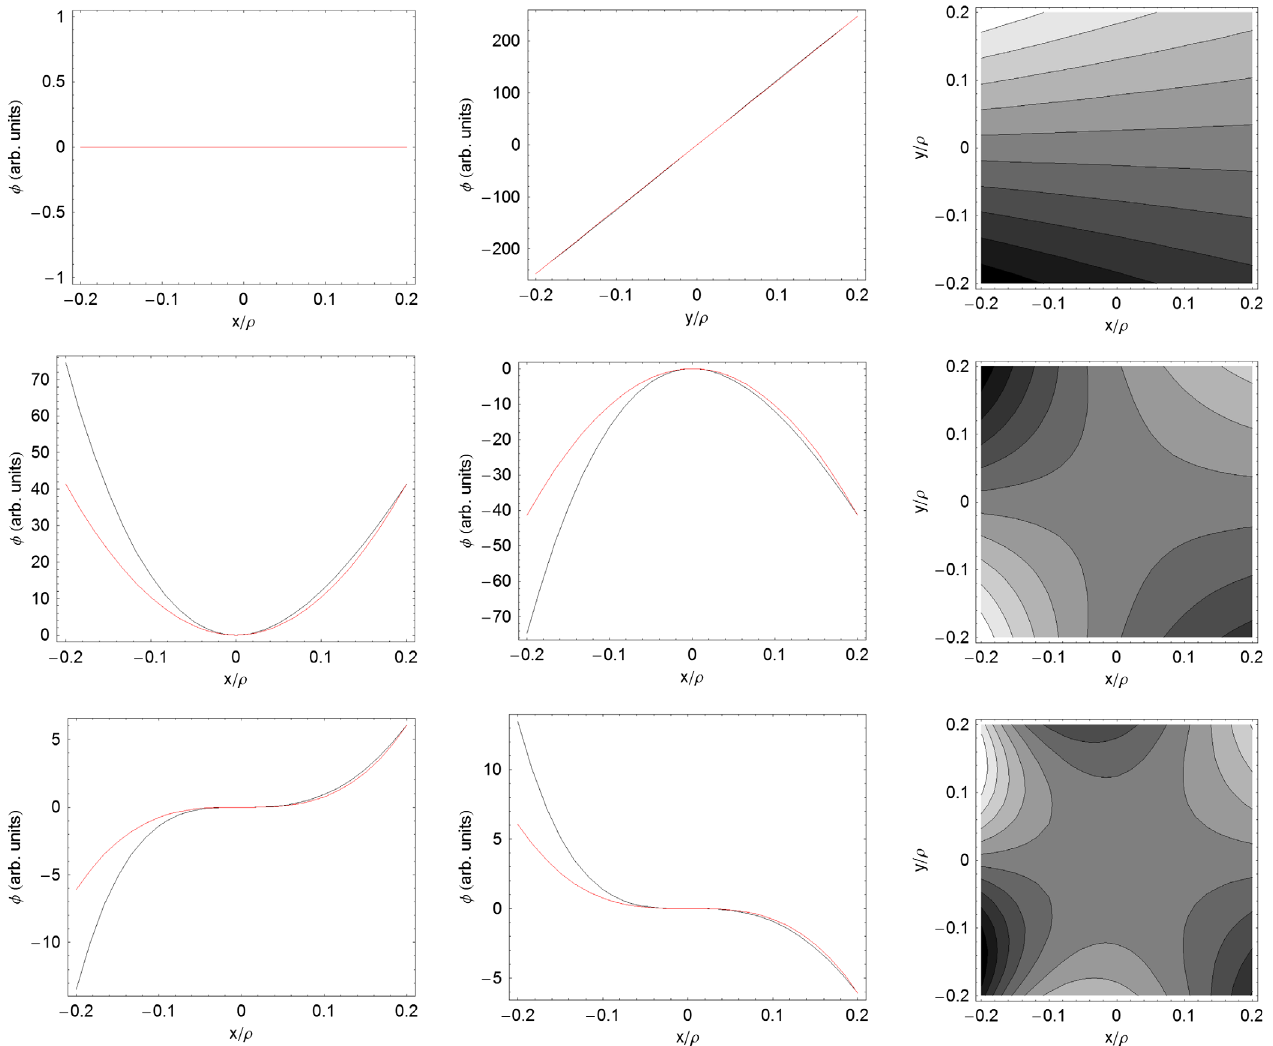
FIG. 3. Scalar potential in skew multipoles with a curved reference trajectory. Each row shows (top to bottom) the potential in a multipole of the order of n ¼ 1 (dipole), the order of n ¼ 2 (quadrupole), and the order of n ¼ 3 (sextupole). The left-hand and middle plots in the top row (dipole) show, respectively, the potential as a function of x , with y ¼ 0 , and as a function of y , with x ¼ 0 (black line). In the middle and bottom rows (quadrupole and sextupole), the left-hand and middle plots show, respectively, the potential as a function of x , with y ¼ x tan ð π = 2 n Þ , and as a function of x , with y ¼ − x tan ð π = 2 n Þ (black lines). The red lines in the left-hand and middle plots show curves ϕ ∝ x n (or ϕ ∝ y n in the top row, middle plot). The right-hand plot in each row shows contours of constant potential in the plane perpendicular to the reference